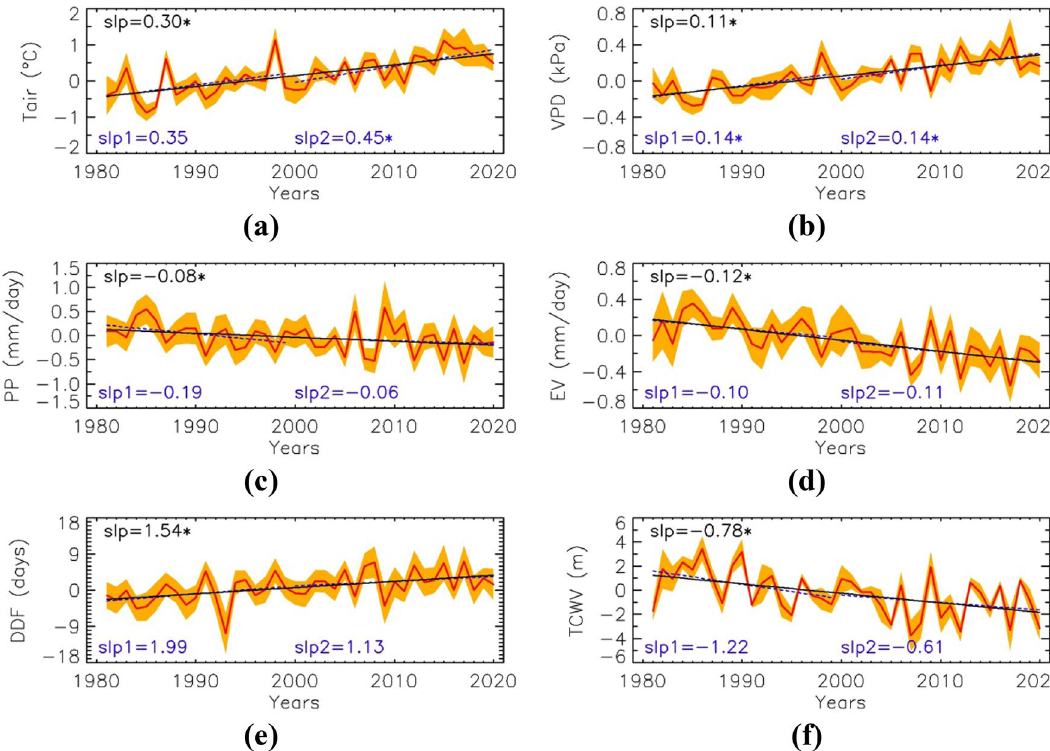
Figure 2. Trends of atmospheric and hydrological variables over the MATOPIBA region. Time series (1981– 2020) of anomalies in air temperature (Tair) ( a ), vapor pressure deficit (VPD) ( b ), precipitation (PP) ( c ), actual evapotranspiration (EV) ( d ), dry-day frequency (DDF) ( e ), and total atmospheric column water vapor (TCWV) ( f ). Slope of the linear trend for the periods 1981–2020 (slp, continuous line), 1981–1999 (slp1, dashed line) and 2000–2020 (slp2, dashed line) are also given. Values statistically significant at p < 0.05 marked with